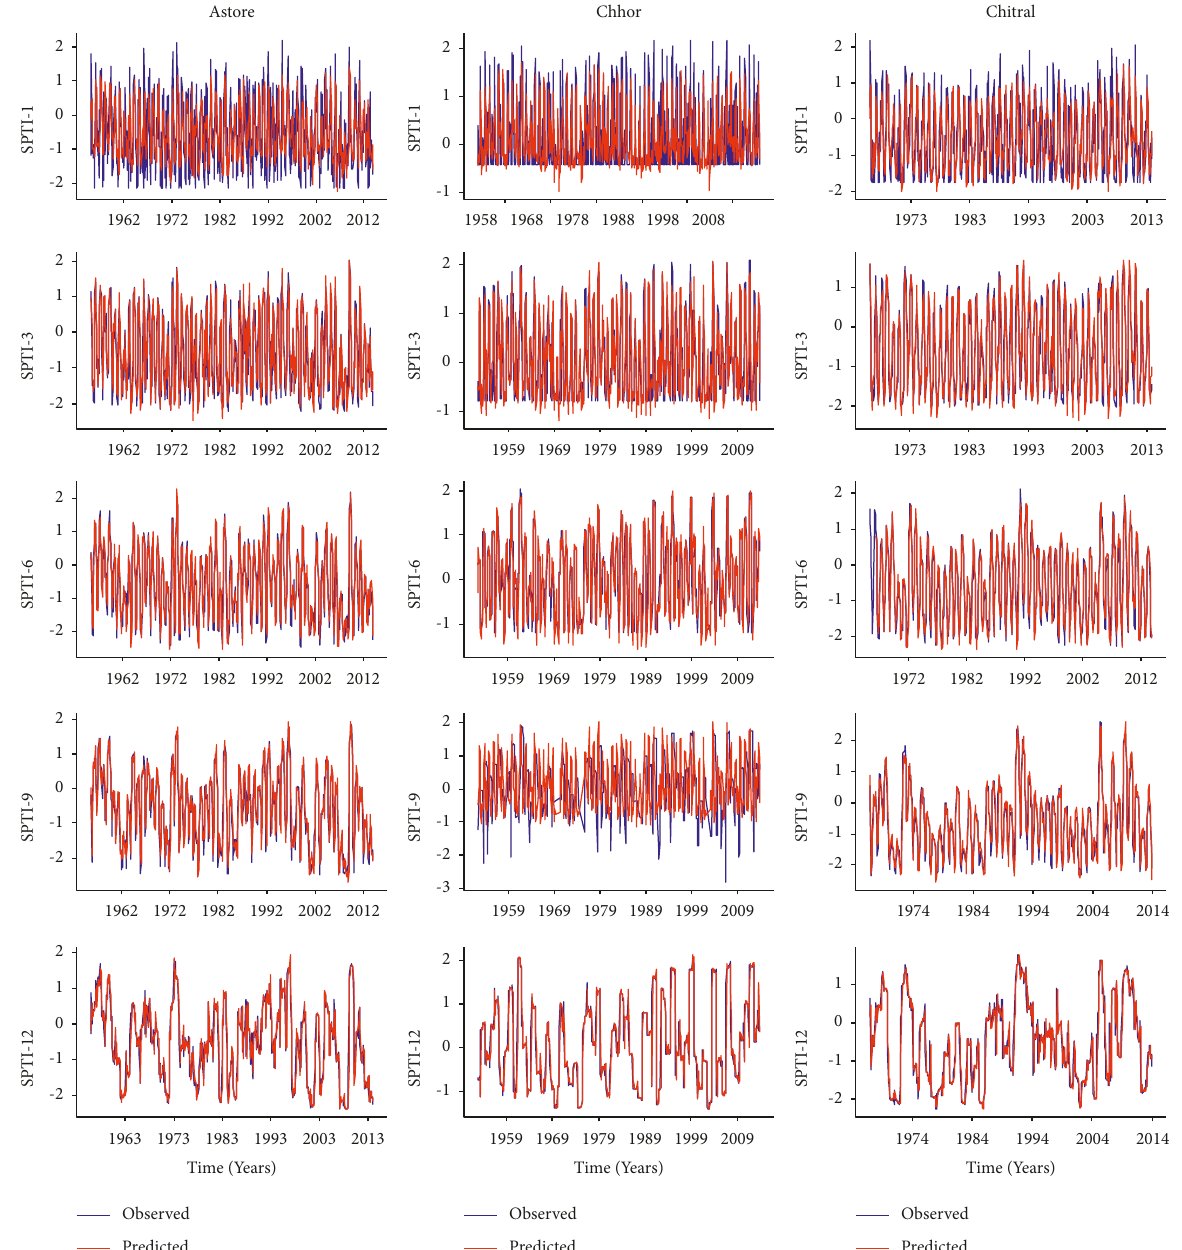
Figure 5: Co-movement of the observed and predicted values of SPTI using ELM at Astore, Chhor, and Chitral stations for the training